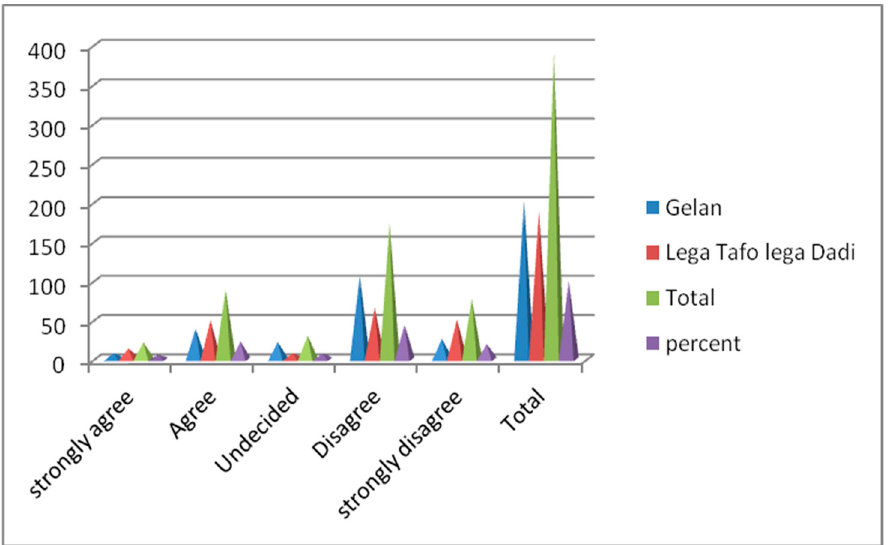
Figure 2. The response rates of household (HH) respondents on the economic development of the town (source: HH survey, 2022).